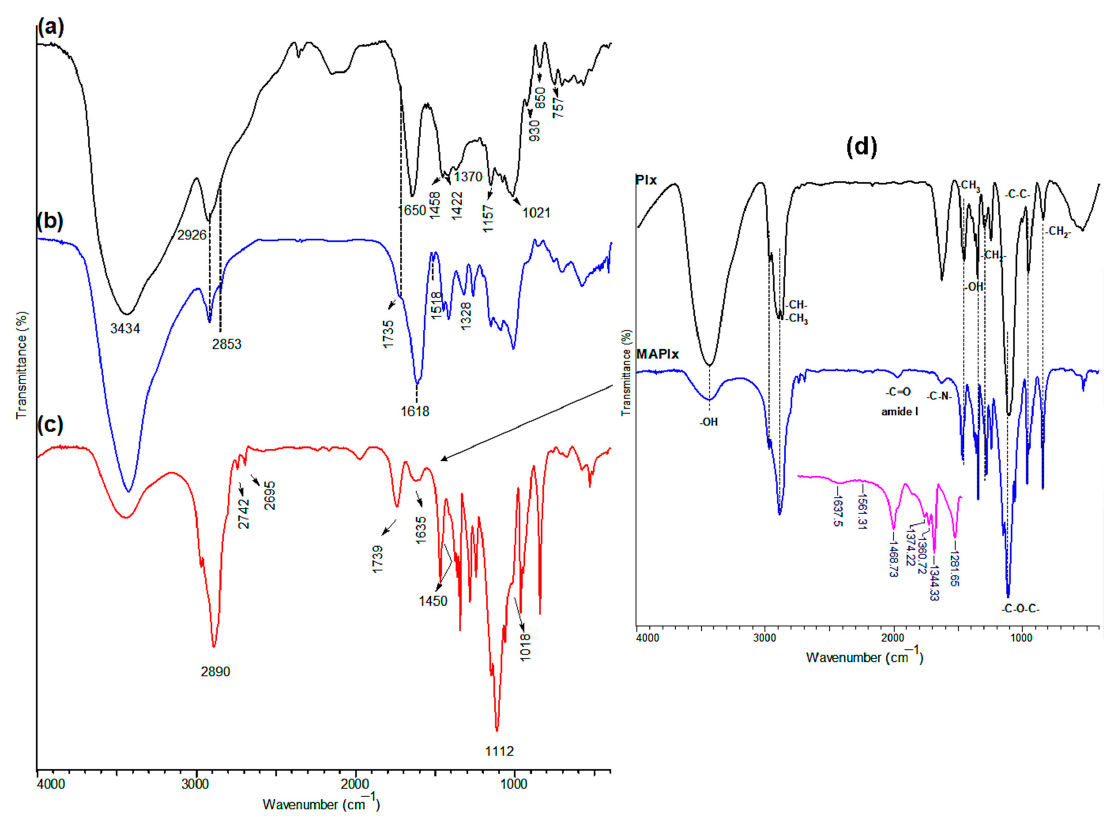
Figure 3. FT-IR spectra of pullulan ( a ), CMP ( b ) and Plx- g -CMP ( c ); for comparison, the FT-IR spectra of Plx and MAPlx are presented ( d ). The density of the grafted polymer measured by the pycnometry method [59] in tet- rahydrofuran (THF) at 25 °C, is 1.336 g/cm 3 and it remains soluble in water and polar solvents (dimethylfuran (DMF), dimethyl sulfoxide (DMSO), etc.), and insoluble in THF, ethyl ether, and chloroform.